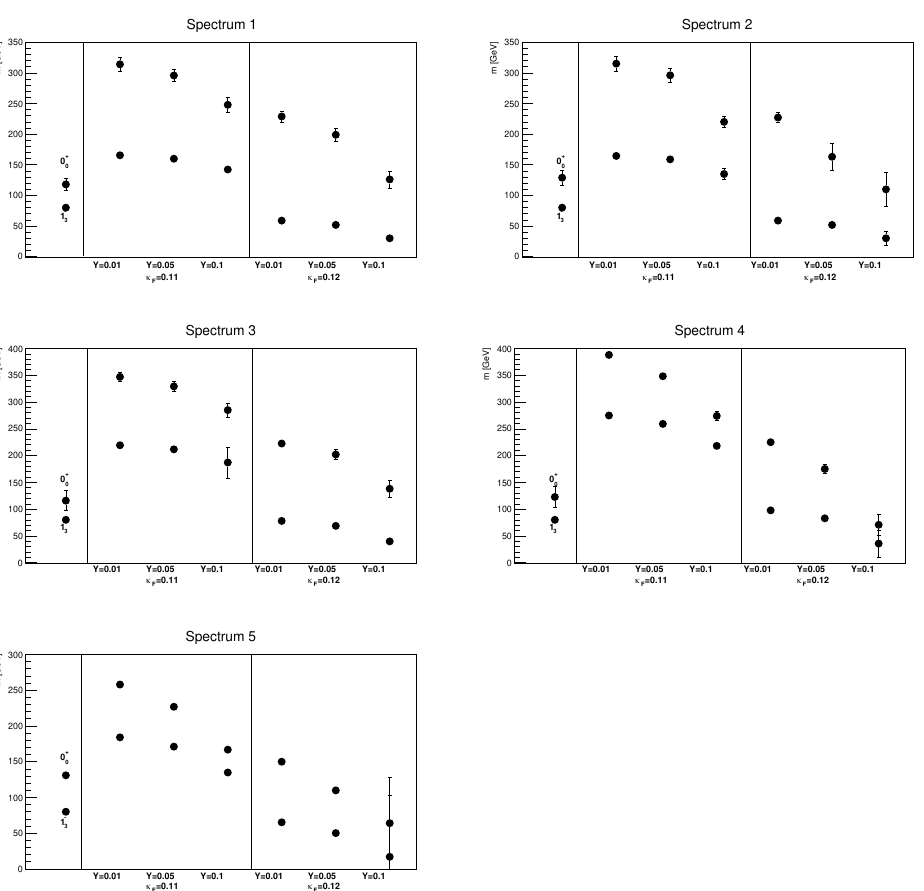
Figure 6: Spectra for all setups. The bosonic sector is fixed, and plotted to the left, while the two states identified in the fermion channel, each being a doublet, are plotted for the different parameters to the